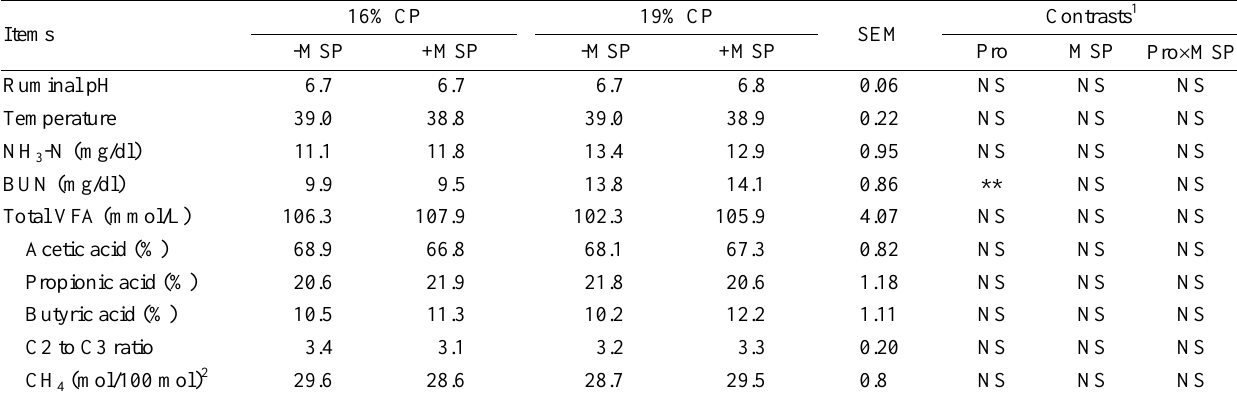
Table 3. Effect of protein level and mangosteen peel pellets (Mago-pel) in concentrate diet on ruminal pH, temperature, NH 3 -N concentration, and volatile fatty acids (VFA)